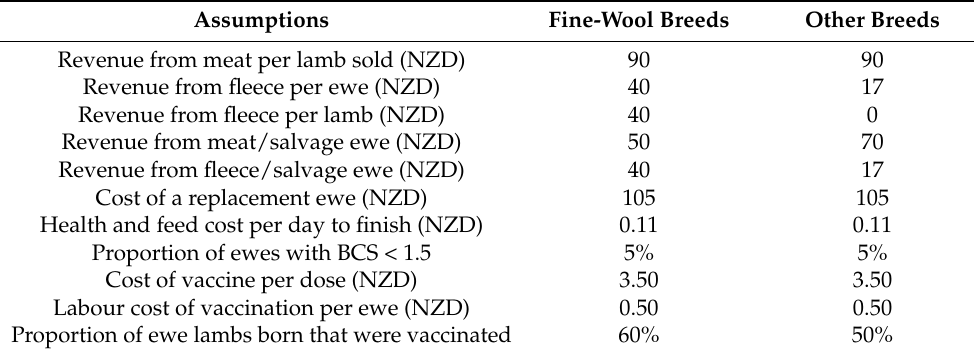
Table 3. Revenue and production cost parameters based on expert opinion. These parameters were held constant for simulation modelling of OJD